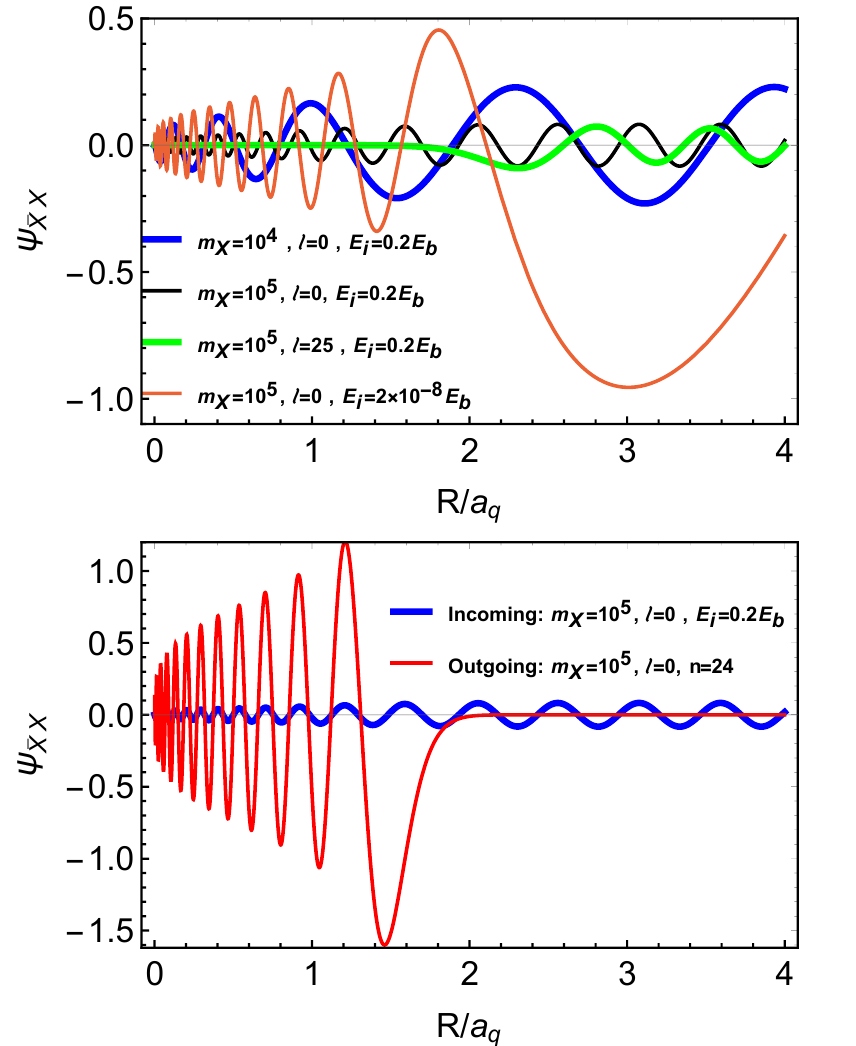
Figure 3. Examples of incoming wavefunctions with various m X ; E i ; l (top) and a comparison of an incoming and outgoing wavefunction (bottom). m X is given in units of the inverse Bohr radius (cid:22) (cid:11) D m q and E b = 1 (cid:22) (cid:11) 2 m q is the H X binding D 2